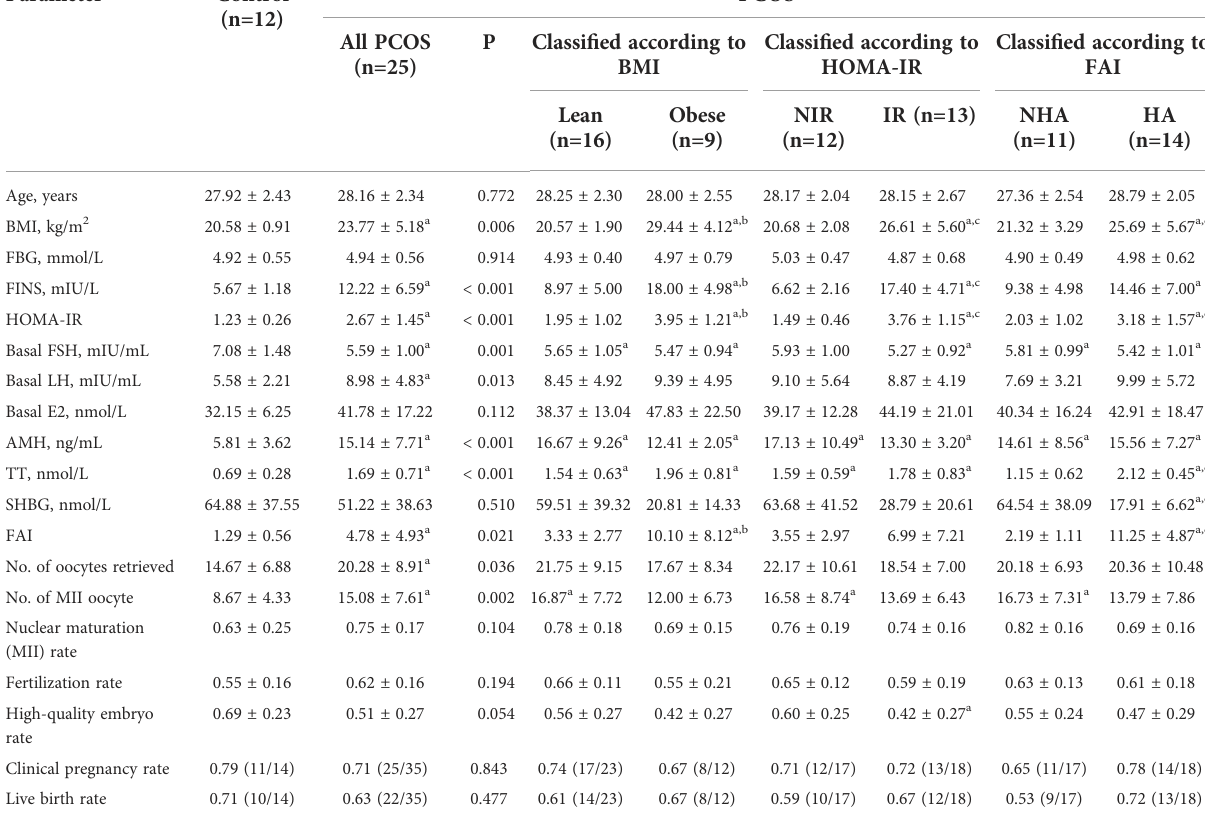
TABLE 1 Demographics and clinical outcomes of women with PCOS and